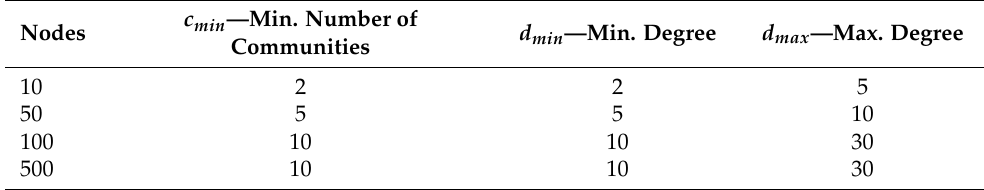
Table 8. Parameters of LFR network generation.